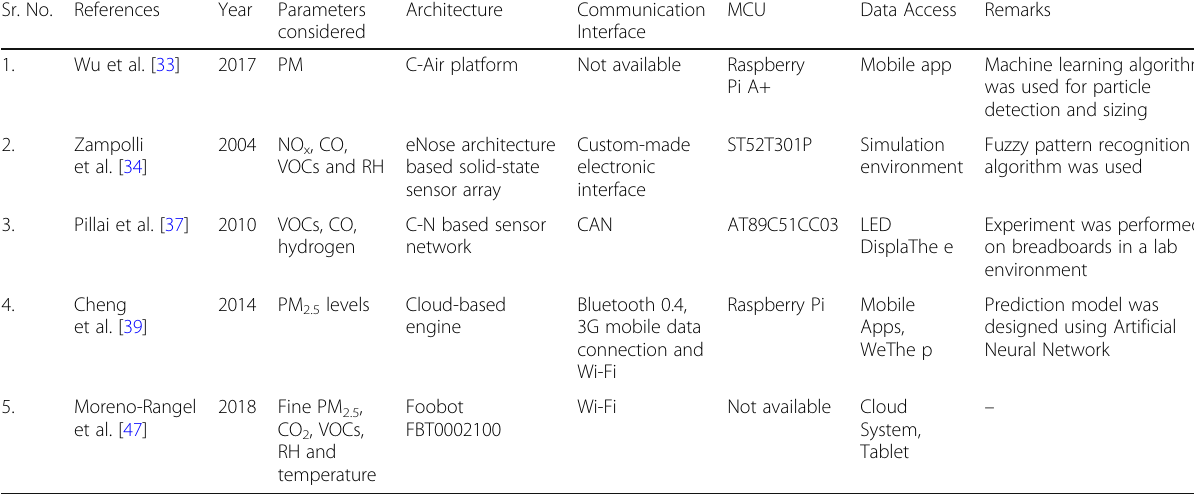
Table 4 Summary of IAQ monitoring systems based on other architectures Sr. No.